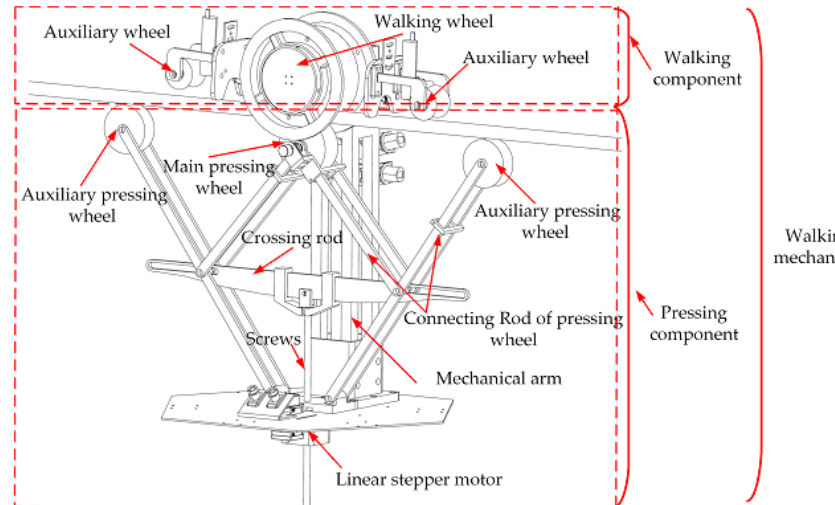
Figure 5. Schematic diagram of the walking